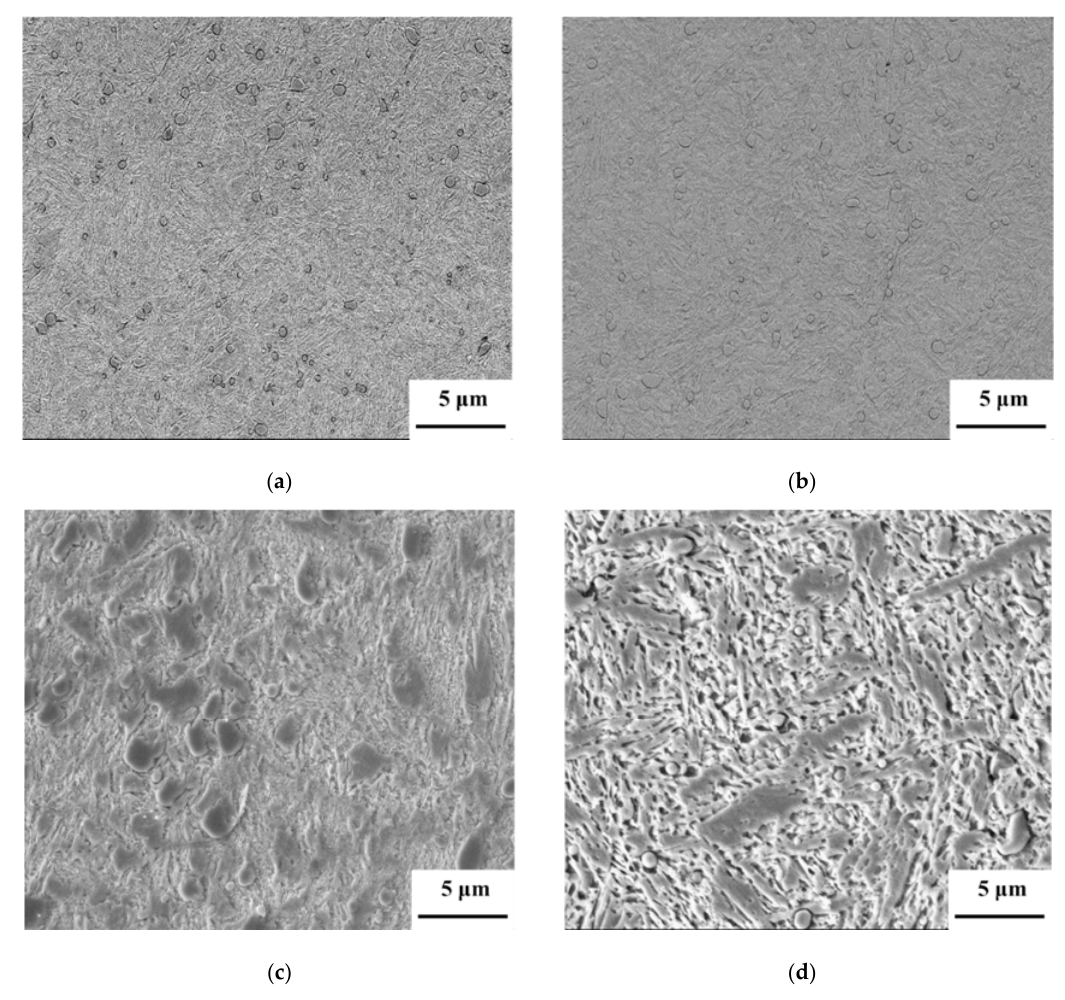
Figure 4. Microstructural characteristics of the austempered specimens (1080 °C ‐ 30 min) with a salt ‐ bath temperature of 300 °C and different salt ‐ bath times: ( a ) 30 min, ( b ) 60 min, ( c ) 90 min, and ( d ) 120 min.